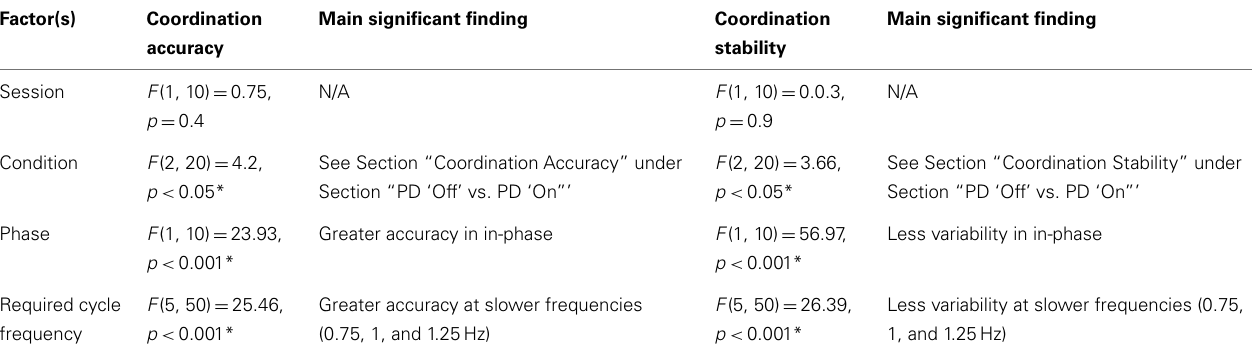
TableA2 | Statistical results fromANOVA analysis on planned comparison between PD “off” and PD “on” to evaluate the effects of dopaminergic treatment on coordination accuracy and